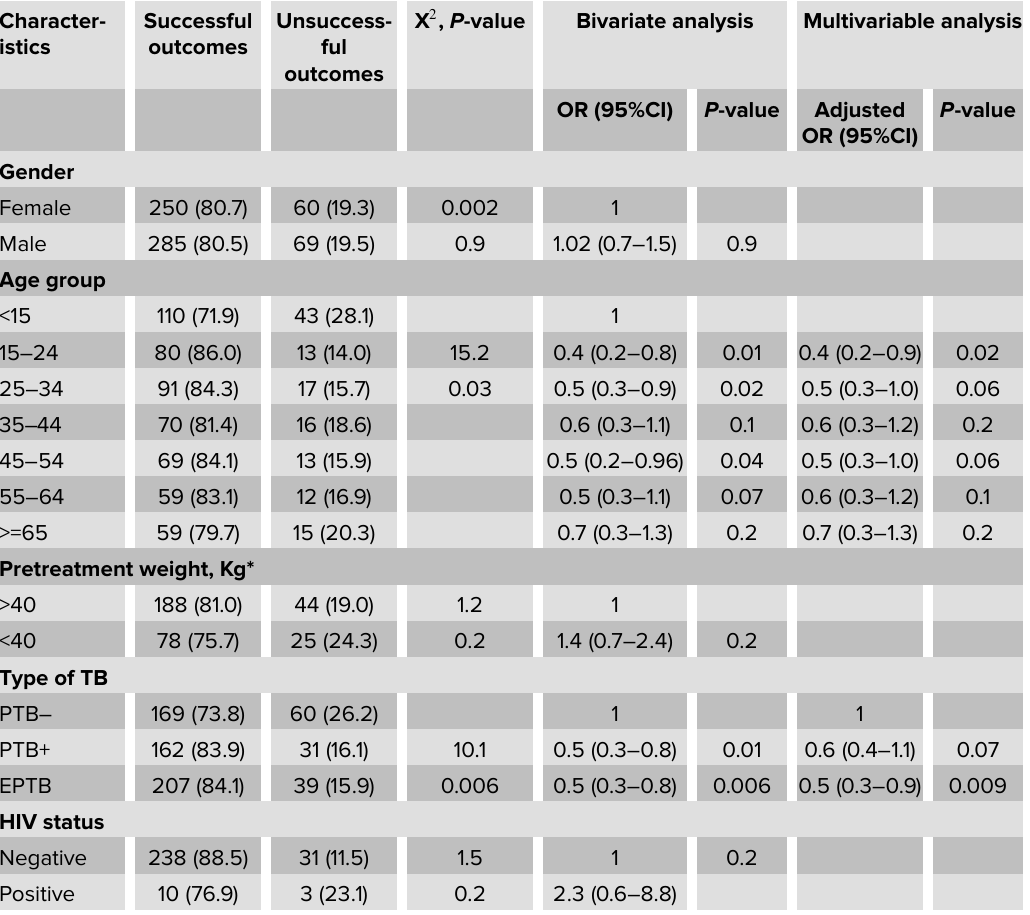
TABLE 3: Demographic and clinical characteristics associated with unsuccessful TB treatment outcomes among all TB cases in Al Kashafa, Wadsherify, and Shagarab refugee camps, Sudan,